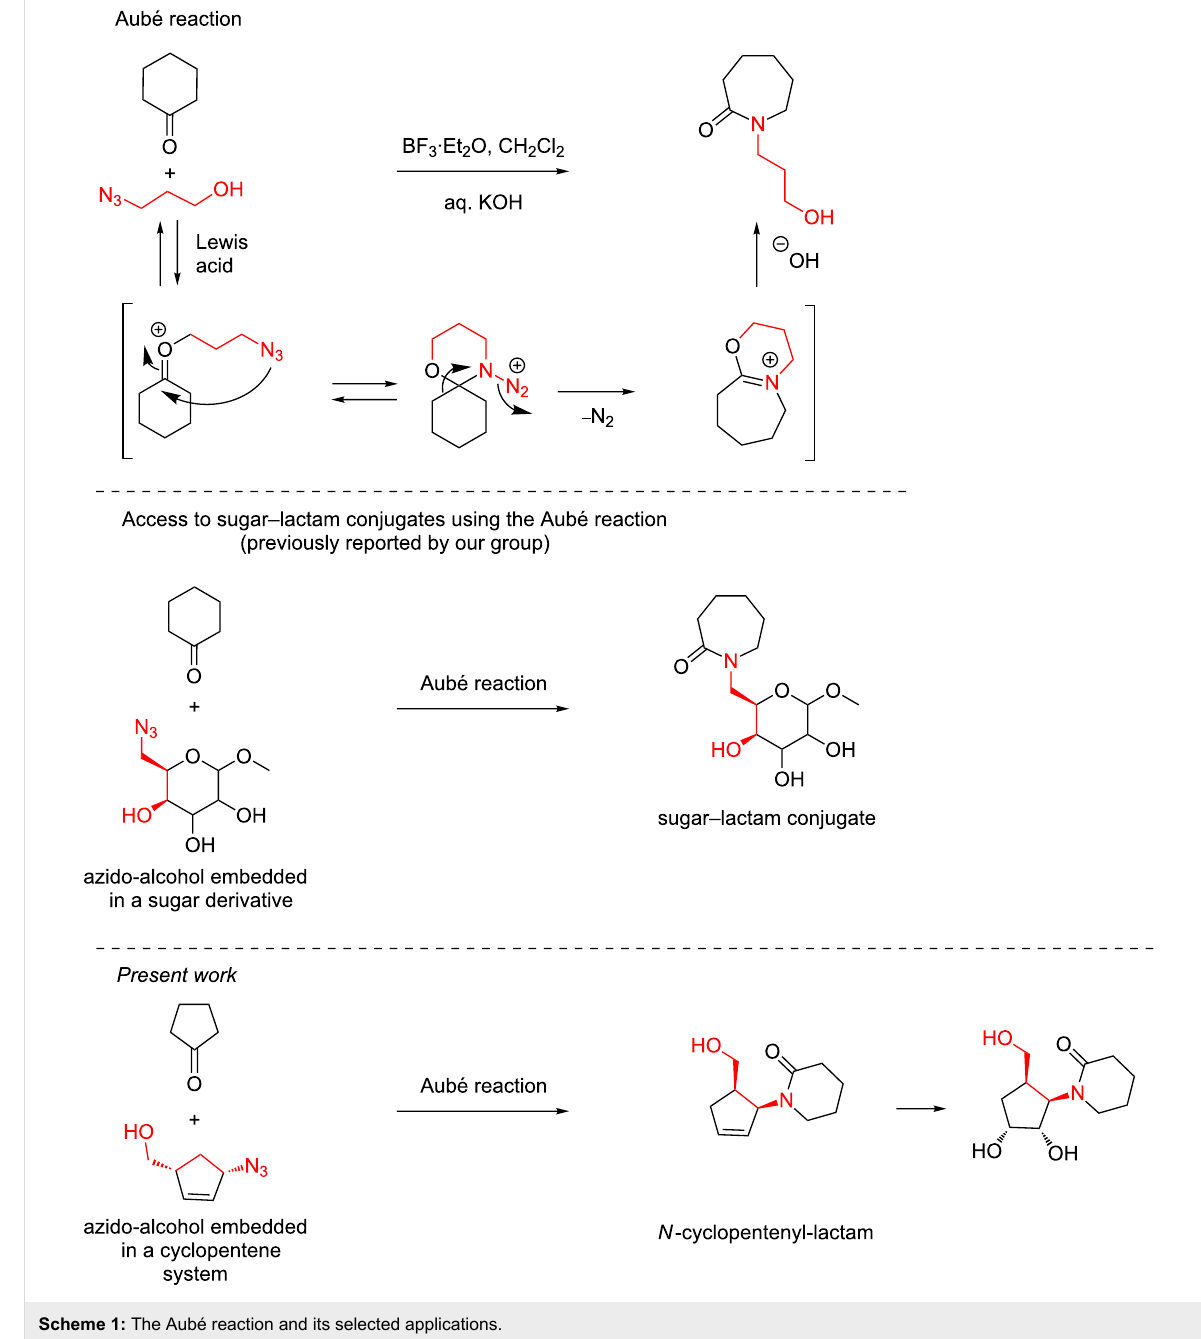
Scheme 1: The Aubé reaction and its selected